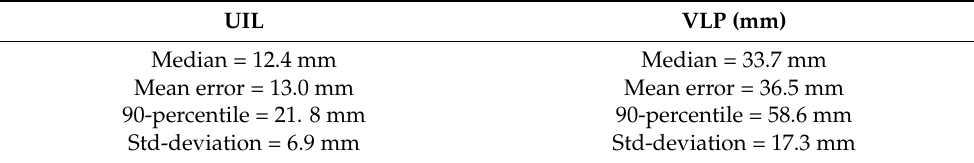
Table 3. Localization accuracy of the UIL compared to